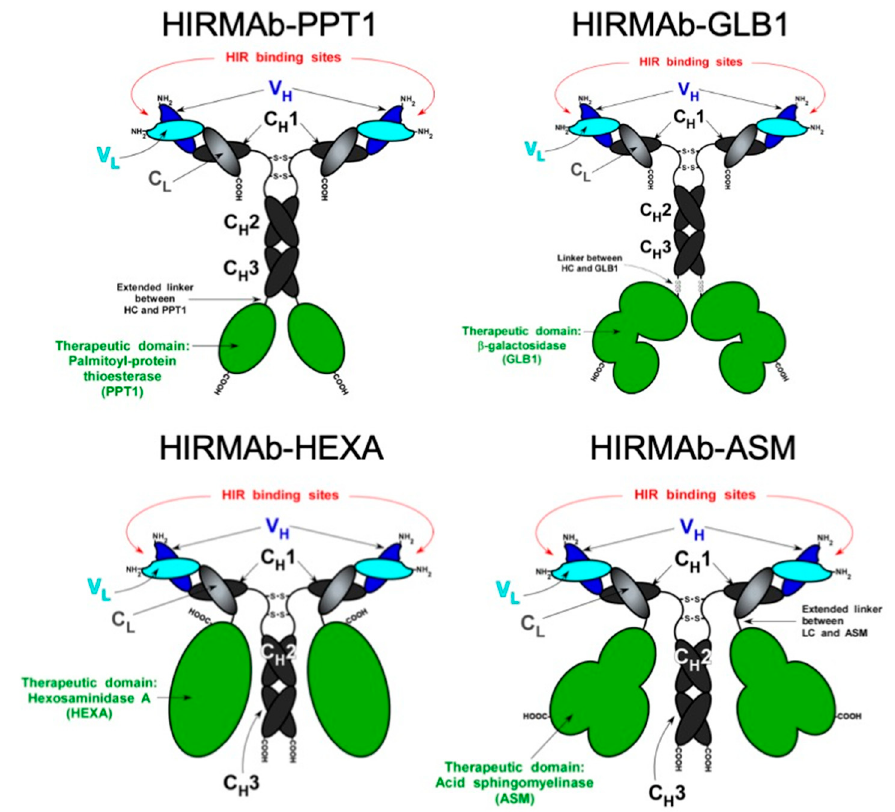
Figure 2. Genetic engineering of IgG fusion proteins. The therapeutic domain of the IgG bifunctional fusion protein can be fused to the C-terminus of either the heavy or light chain of the transport monoclonal antibody (MAb), in this case targeting the BBB human insulin receptor (HIR). The indi- cation for these IgG fusion proteins is: HIRMAb-PPT1, Batten disease type 1; HIRMAb-GLB1, GM1- gangliosidosis; HIRMAb-HEXA, Tay–Sachs disease; and HIRMAb-ASM, Niemann–Pick disease types A and B. From reference [28].